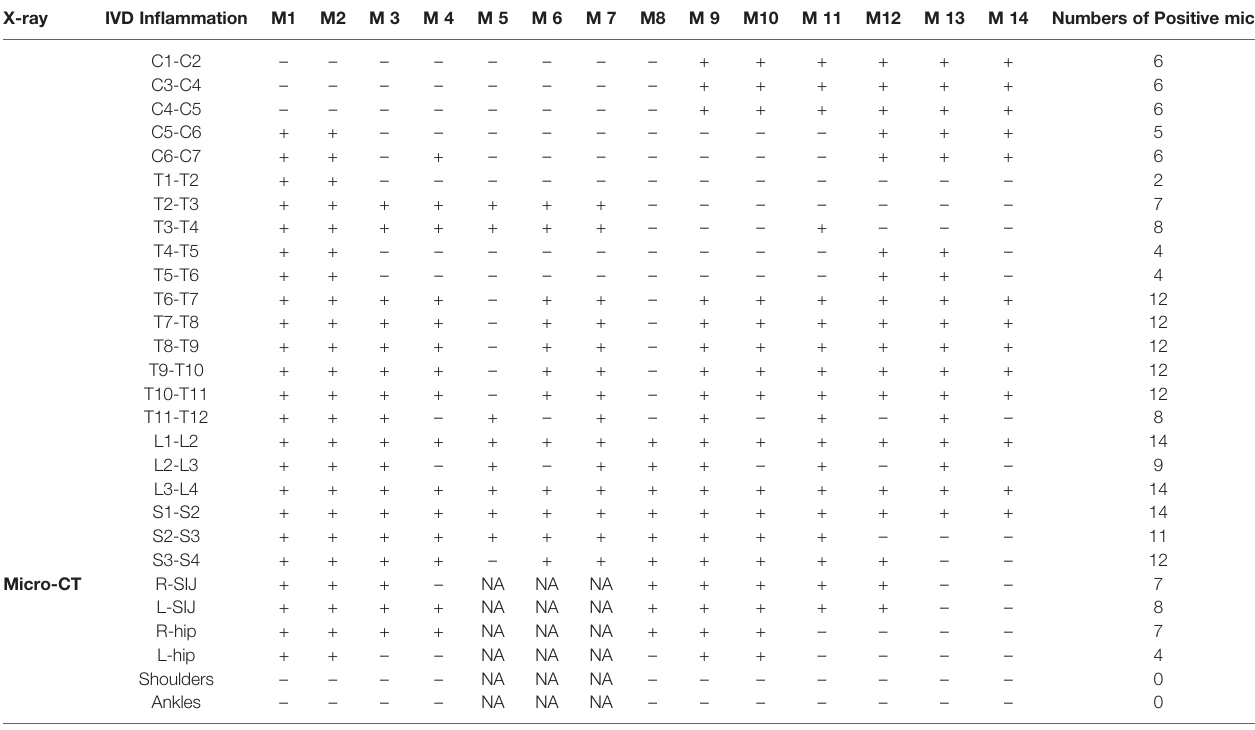
TABLE 1 | X-ray/Micro-CT assessment of individual intervertebral space as well as sacroiliac and hip joints in PGISp mice.